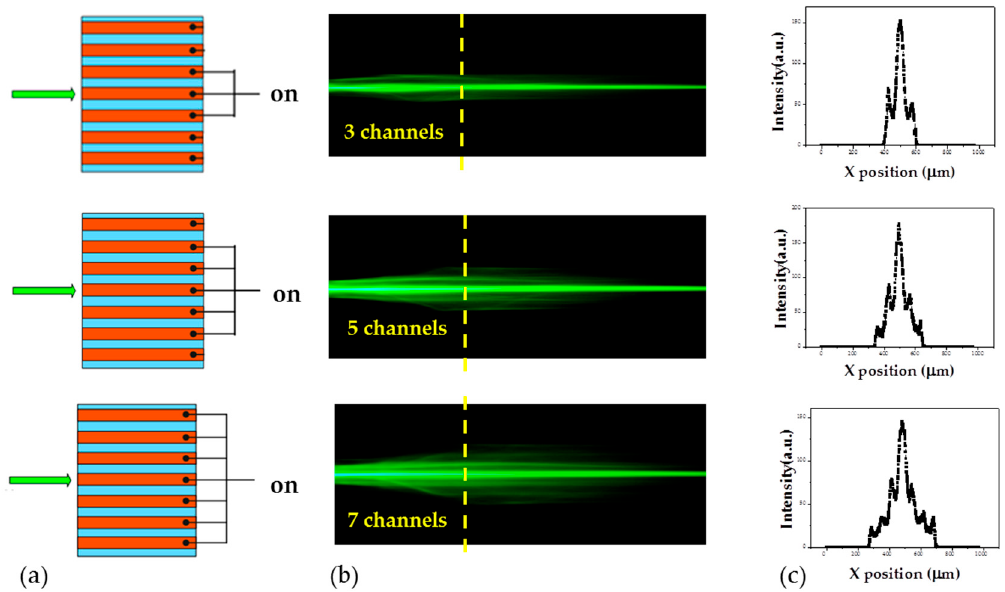
Figure 9. Beam coupling into multiple channels. ( a ) Schematics for the incident position of the laser beam and the electrode channels with the applied voltage of 2.8 V. ( b ) The top view of the propagation of laser beams coupled into three, five, and seven channels, respectively. ( c ) The intensity distributions of the laser beam at the positions labeled by the yellow dash lines shown in ( b ).